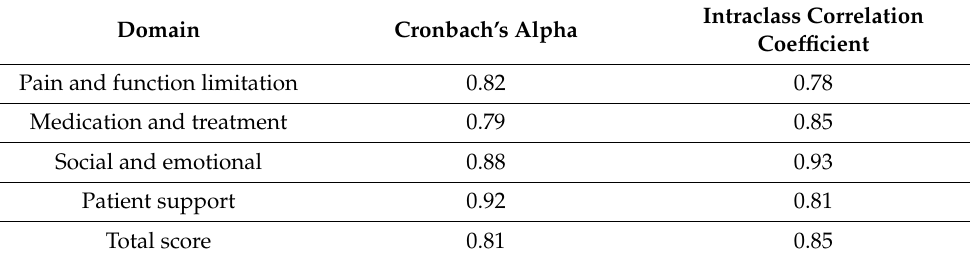
Table 2. Reliability analysis of the Urdu version of